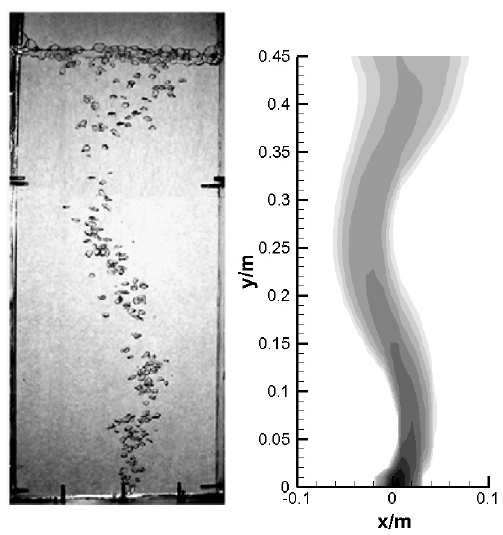
Figure 3. Comparison of the experimental and computational instantaneous gas hold-up results.